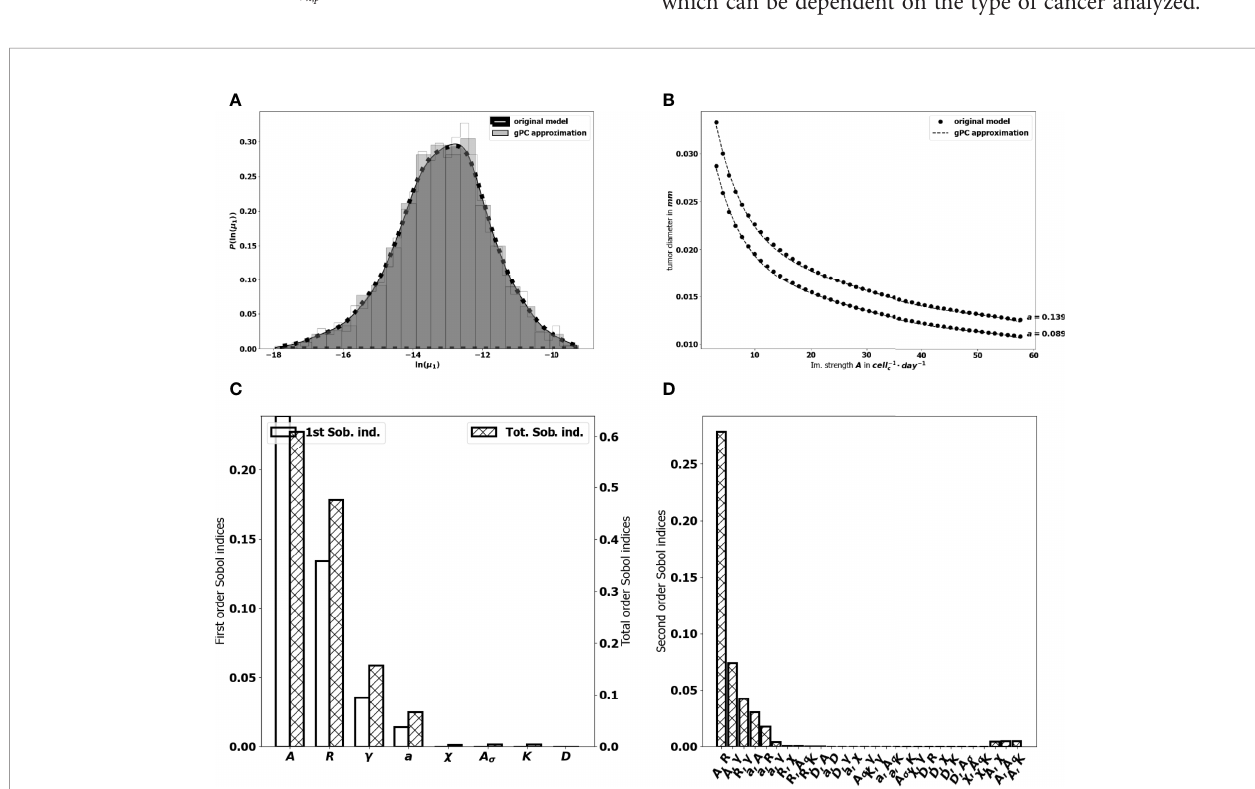
FIGURE 8 | (A) comparison between the pdf of In ( m 1 ) from the gPC approximation and the pdf from the original model. (B) Comparison between the value of m 1 generated by the power-dichotomy algorithm and the gPC approximation. (C) First (empty, left scale) and total (dashed, right scale) order Sobol indices for m 1 . (D) Second order Sobol indices for m 1